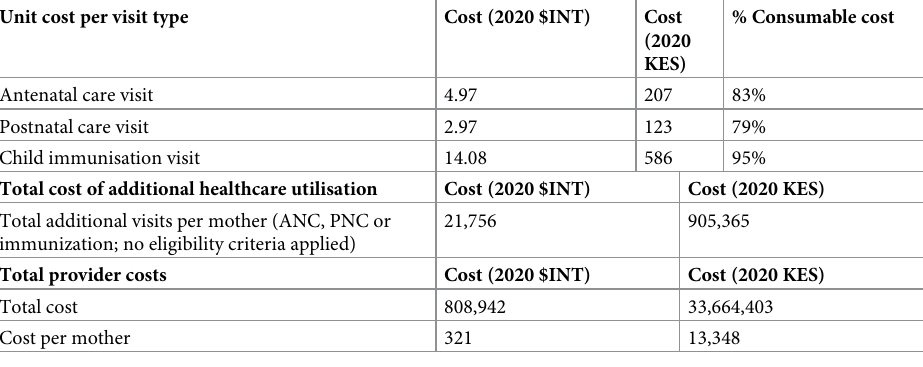
Table 3. Provider costs.